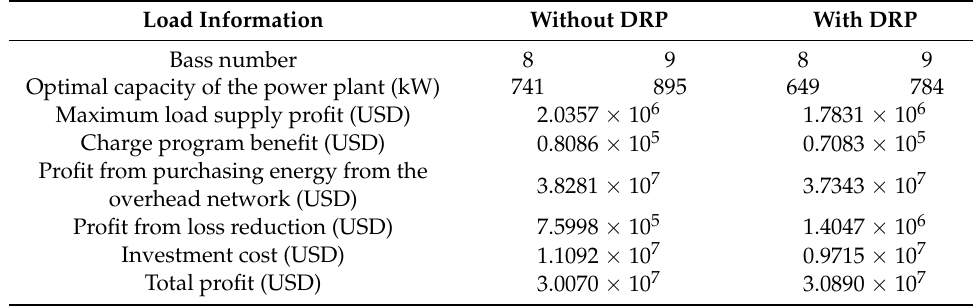
Table 5. Simulation results for the location of two electric vehicle parking lots.